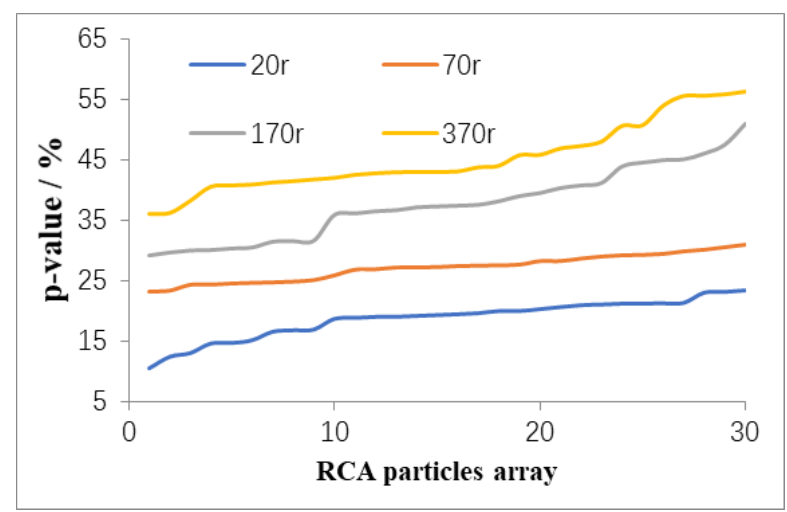
Figure 13. Variation in p -value under surface treatment.